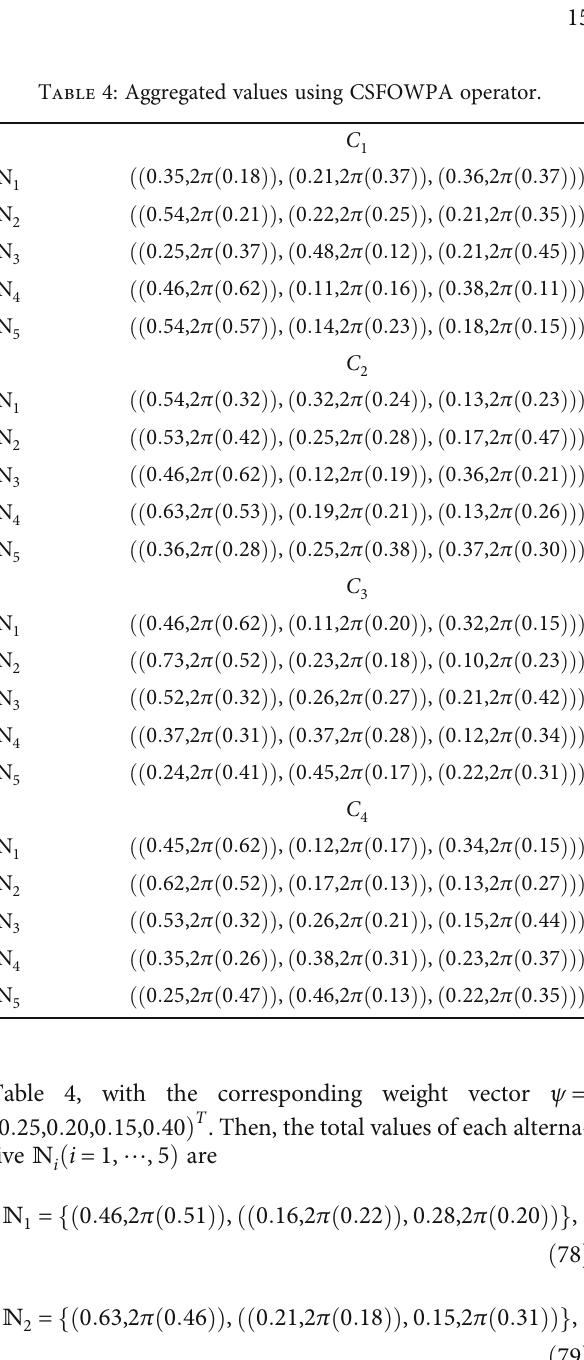
Table 4: Aggregated values using CSFOWPA operator.